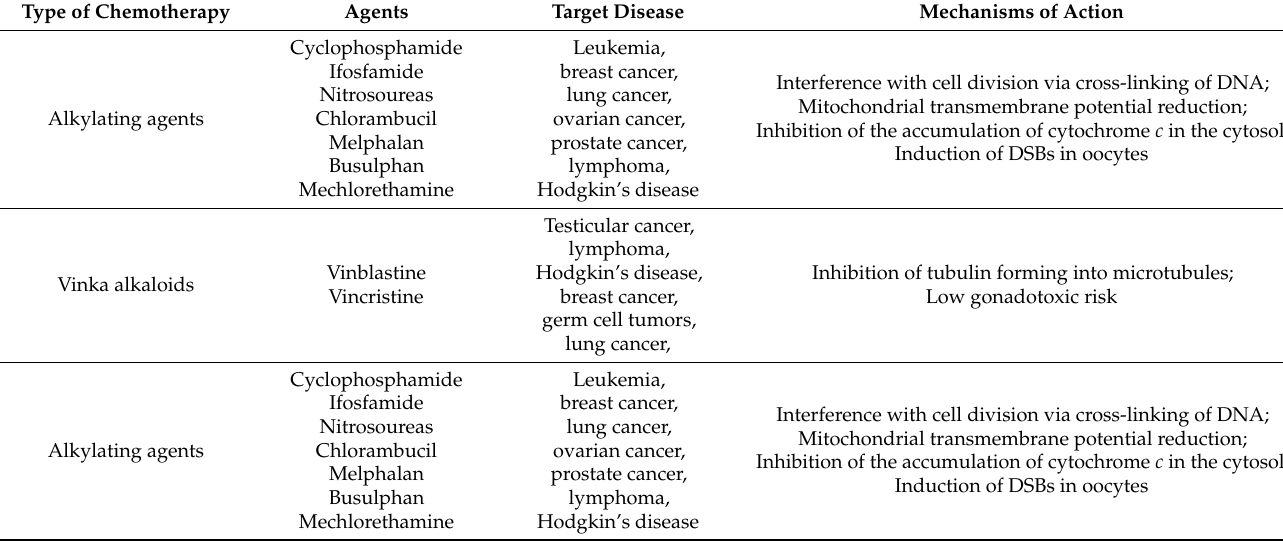
Table 2. Ovarian damage with chemotherapeutic agents and their mechanisms of